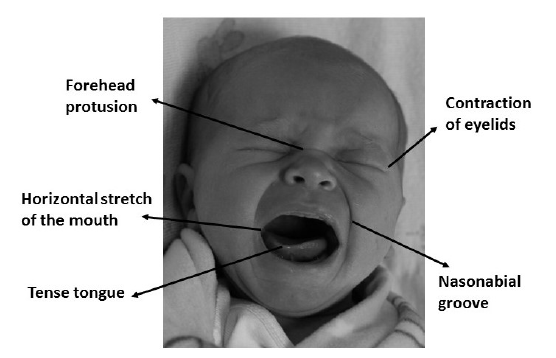
Figure 1. Facial expression of physical distress is the most consistent behavioral indicator of pain in infants.